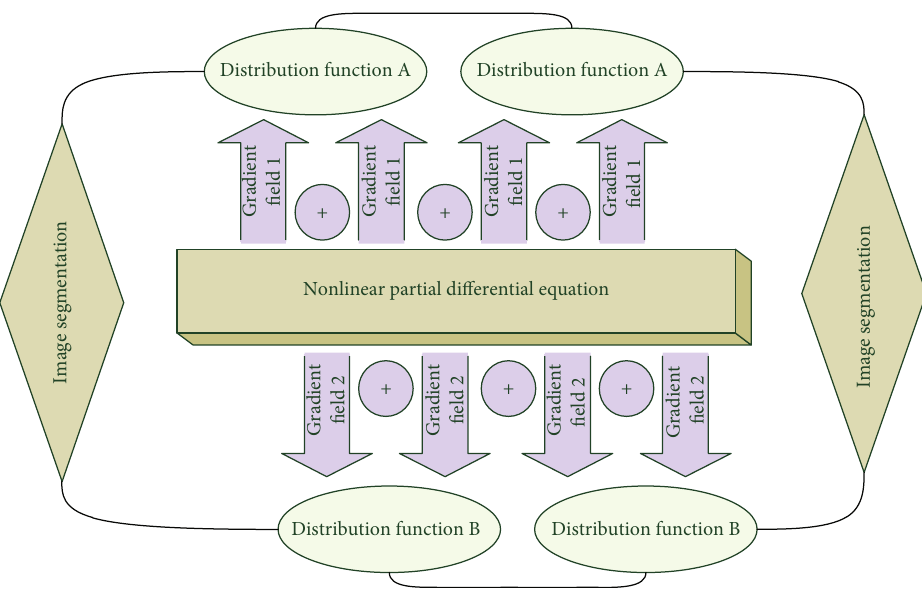
Figure 1: Partial di ff erential equation distribution spatial relationship